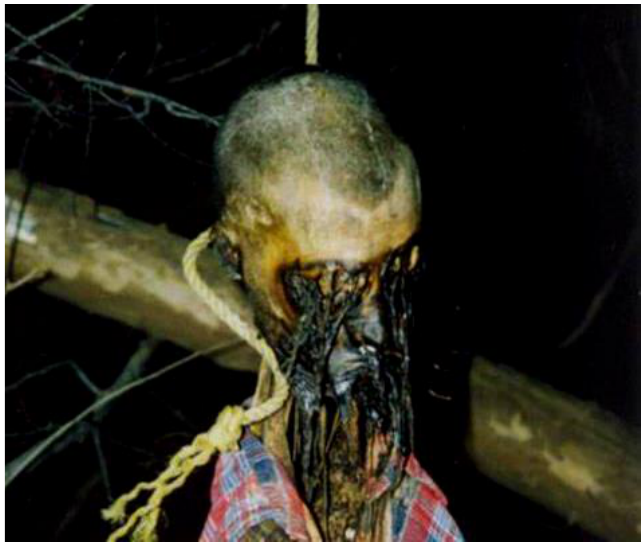
Figure 1. Corpse found with extensive putrefactive phenomena that did not allow the evaluation of common parameters for formulating a diagnosis of